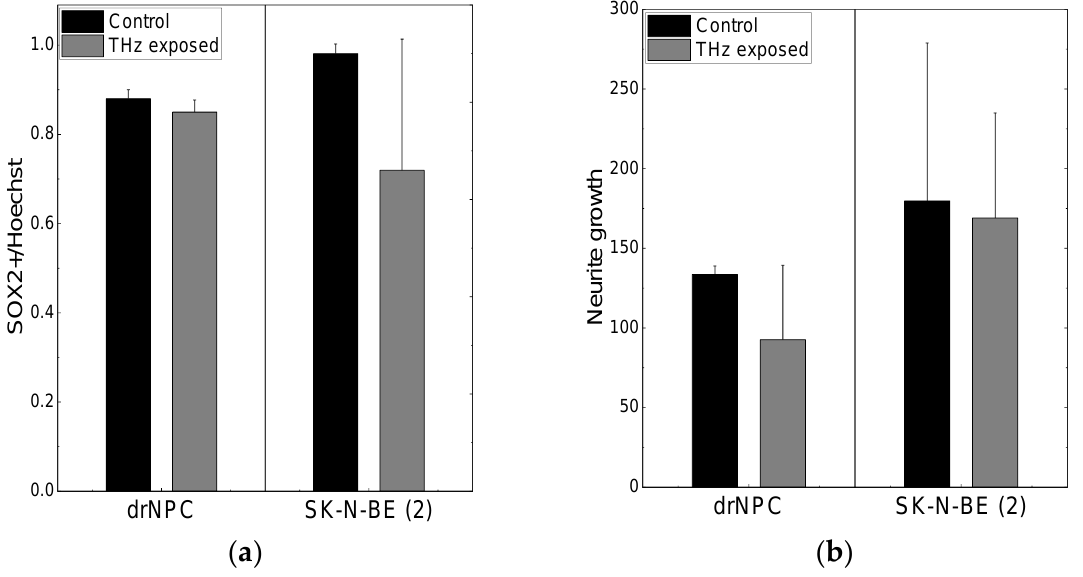
Figure 2. THz radiation effect on differentiation of drNPC and SK-N-BE (2): ( a ) The ratio of the number of SOX2-positive cells to the total number of cells in the experimental groups and in the parallel control groups; ( b ) the growth of neurites (µm) based on the analysis of β -III-tubulin expression in the irradiated cells and in the parallel control groups.